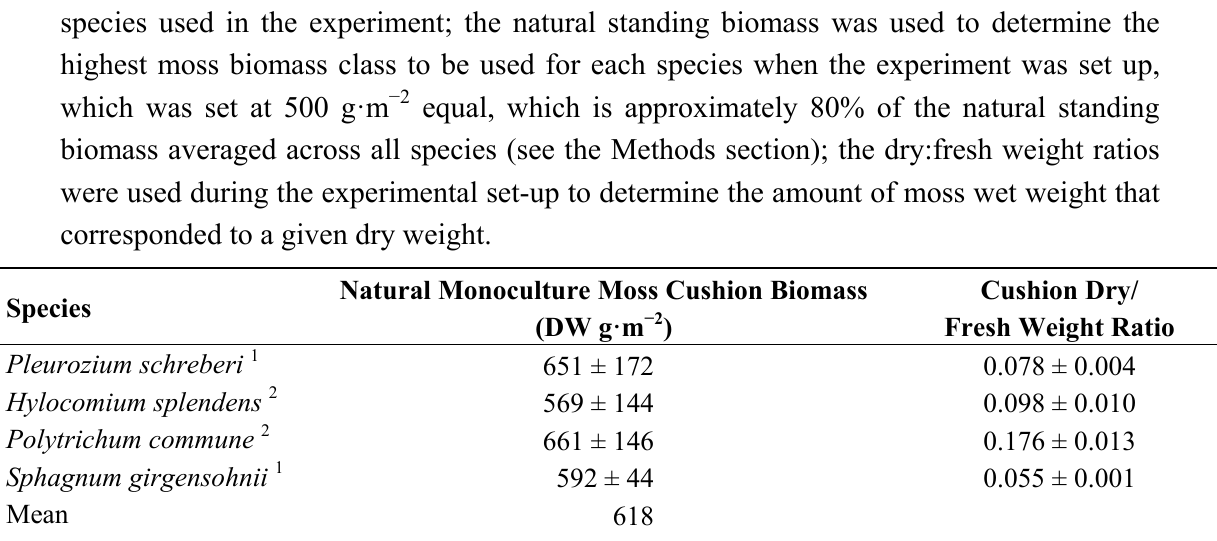
Table S1. Natural standing biomass (mean ± SE) of monospecific moss cushions